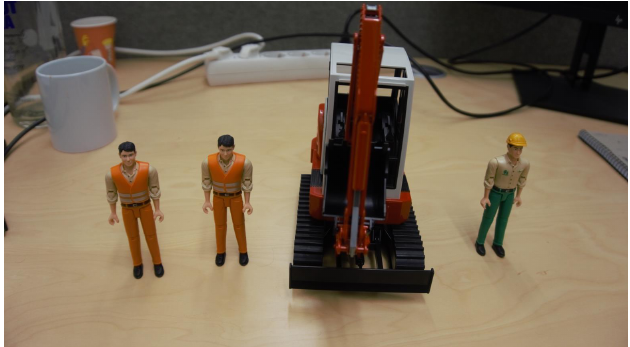
Figure 12. The toys that were used to visualize the logic behind the proposed concepts, as well as to test the operators’ understanding on the proposed concepts. In this study, the human toys were used as a representation of obstacles that may exist around the